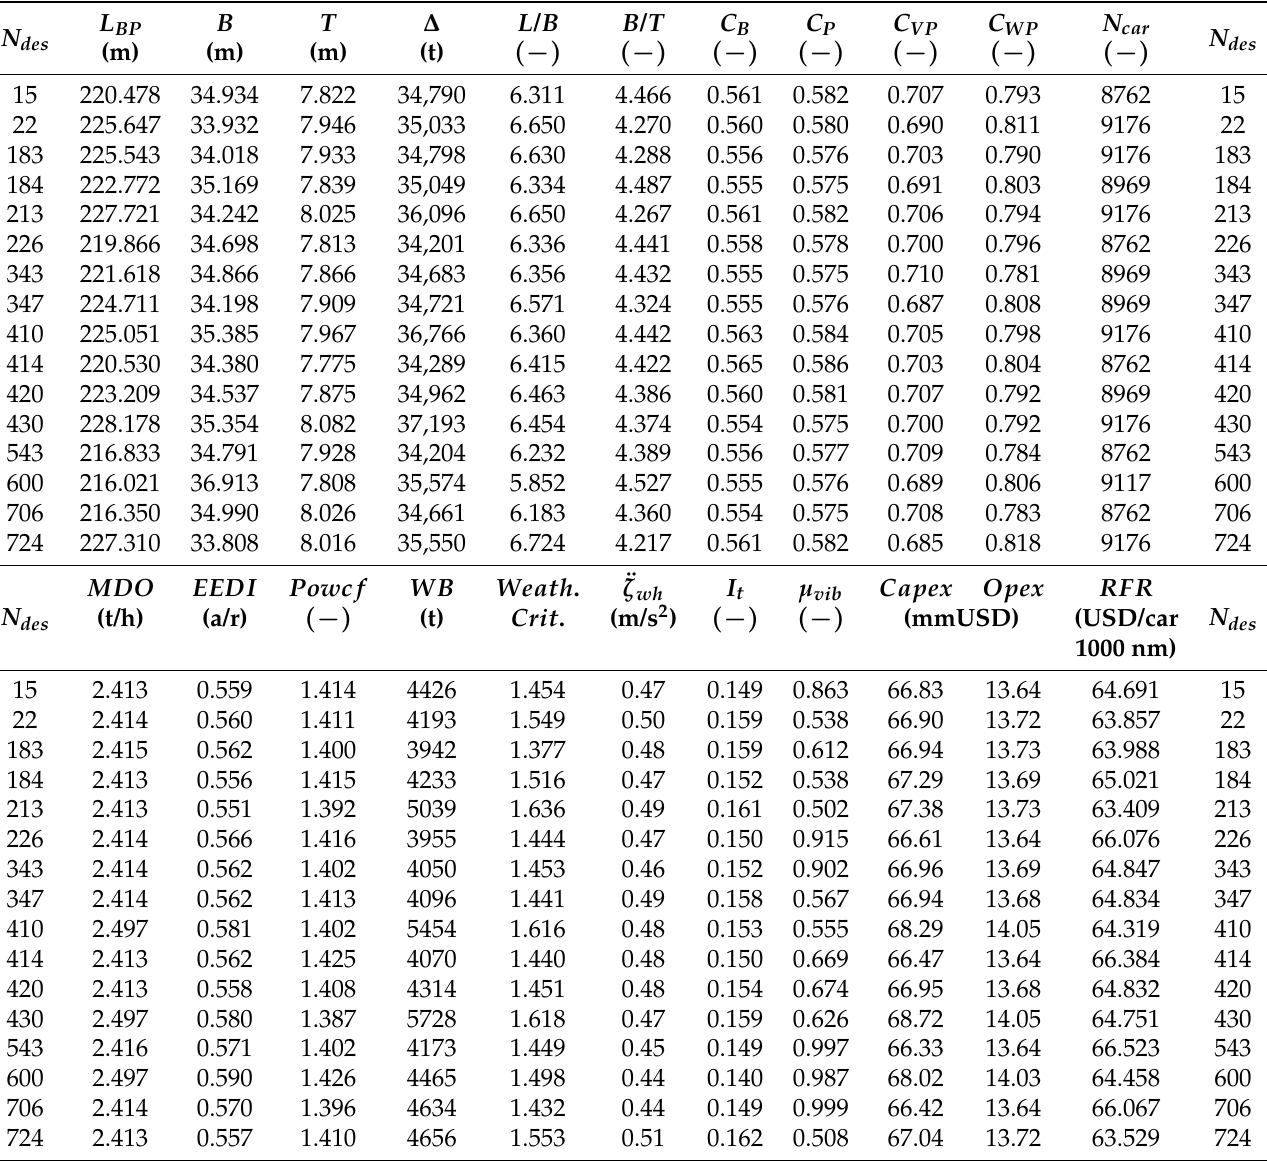
Table 7. Main characteristics of non-dominated